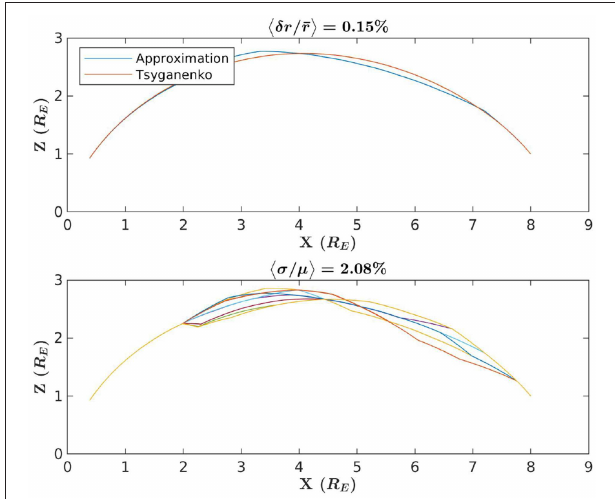
FIGURE 11 | The top image conveys the same information as the images in Figure 9 , but the launch point for this example is chosen to be away from the equatorial plane. The bottom image likewise conveys the same information as the images in Figure 10 but for a launch point away from the equatorial